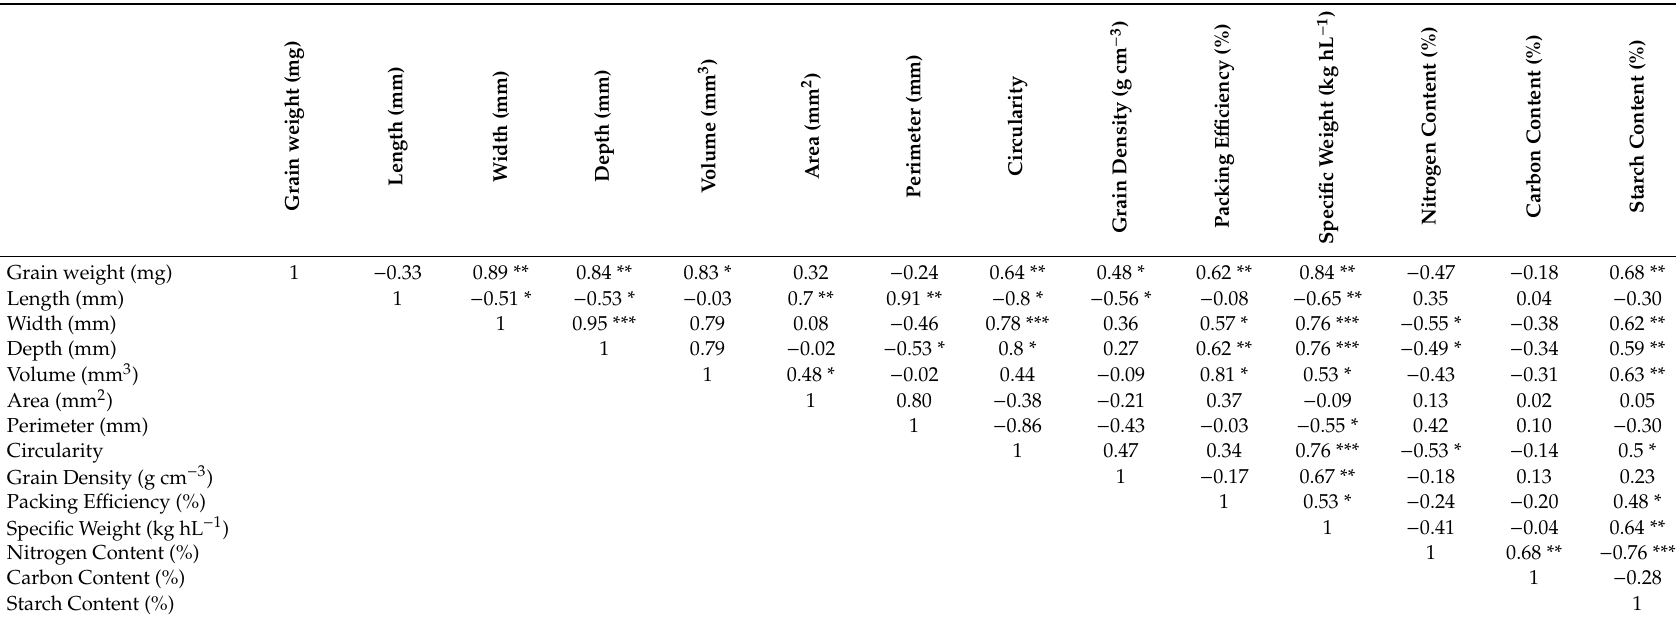
Table 2. Correlation matrix of Pearson correlation coe ffi cients (r) for grain